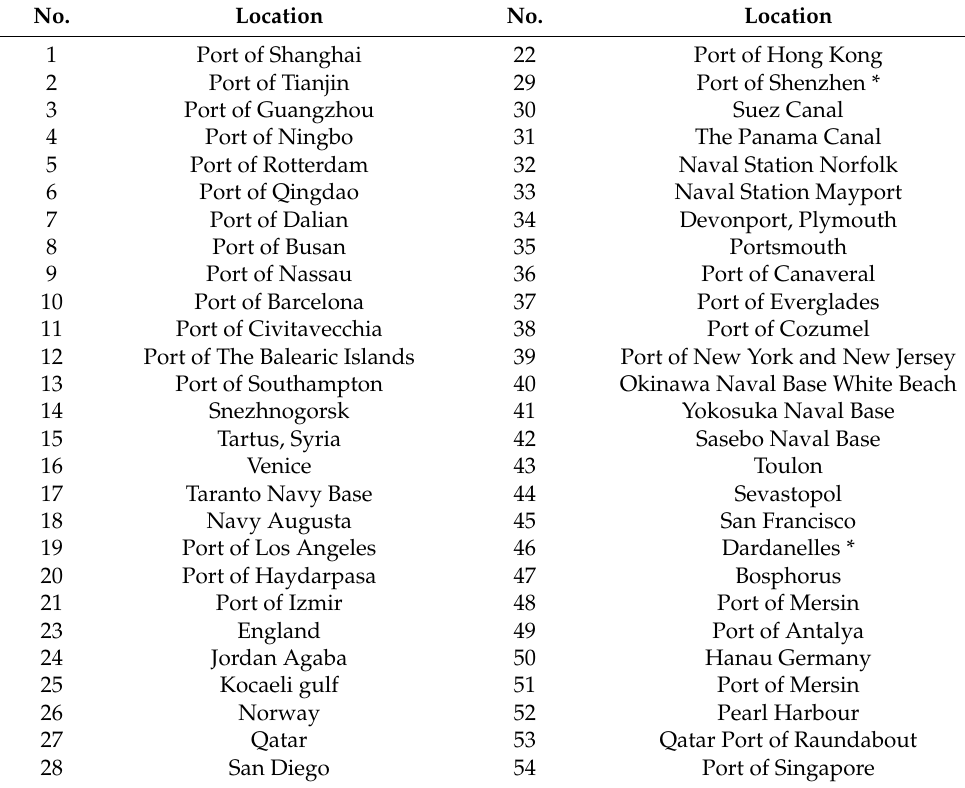
Table A1. Geographic locations of images collected to create VHRShips